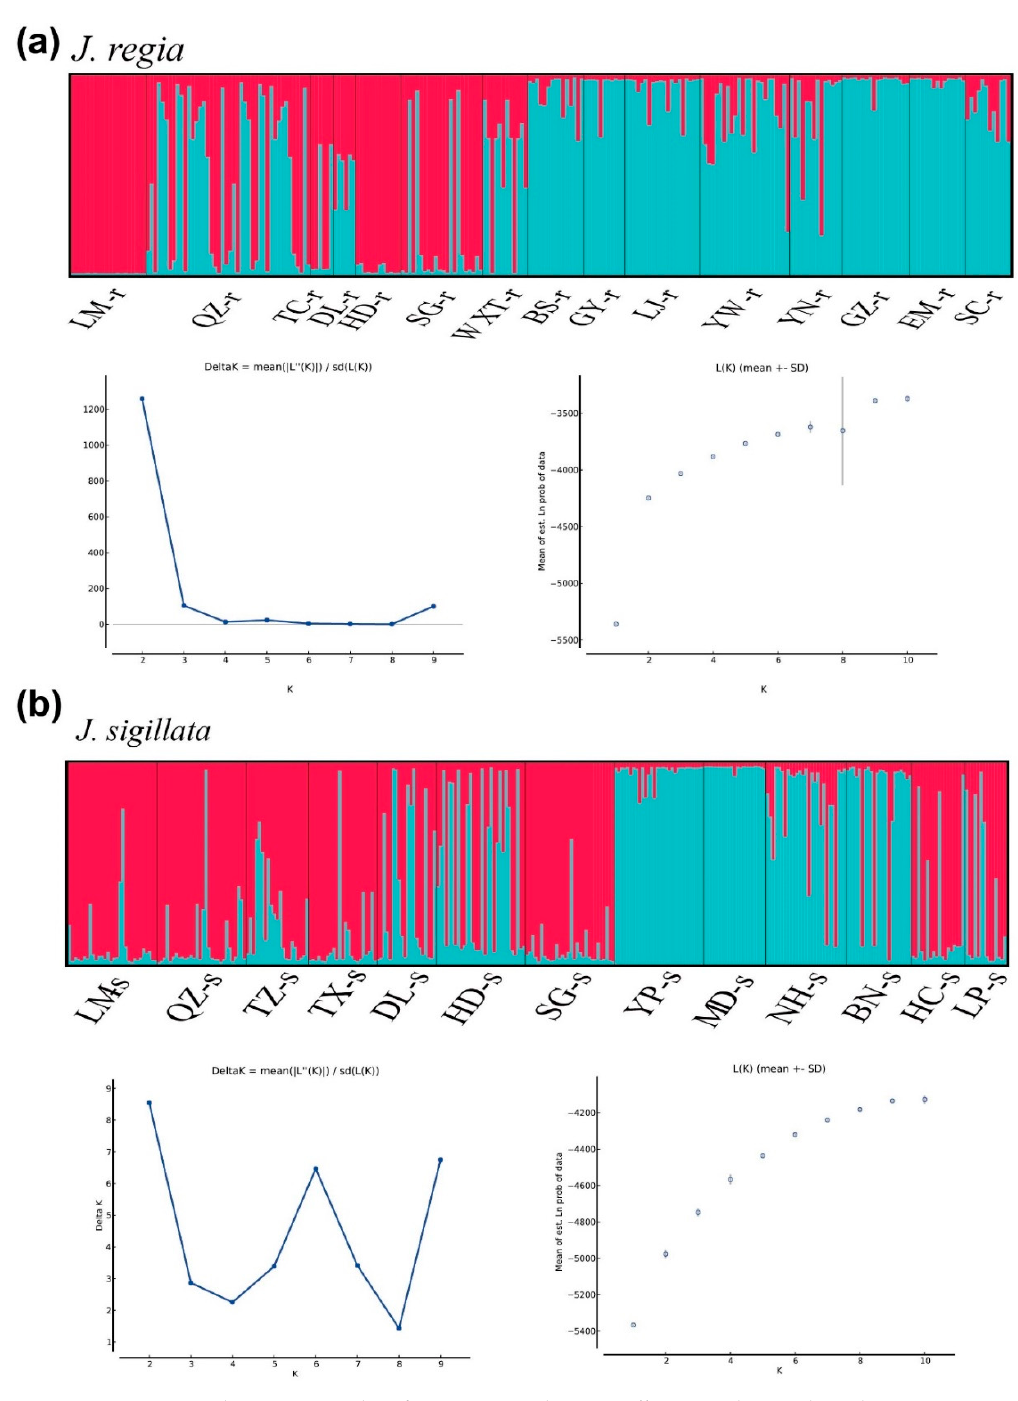
Figure 2. Structure clustering results of 15 J. regia and 13 J. sigillata populations based on variation at 15 neutral microsatellite loci. ( a ) The population structure based on 15 J. regia populations at K = 2 as determined using the deltaK method of Evanno et al. [34]. ( b ) The population structure based on 13 J. sigillata populations at K = 2 as determined using the deltaK method of Evanno et al. [34].